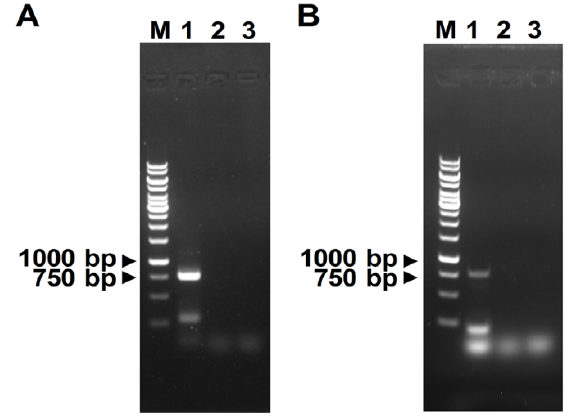
Figure 3. Strand-specific RT-PCR detection of the positive-strand ( A ) and negative-strand ( B ) RNA of watermelon mosaic virus. Lane M, DNA marker (Thermo). Lane 1 and Lane 2 indicate cDNA transcribed from diseased and healthy cotton leaves, respectively. Lane 3 indicates that double-distilled water was used as the negative control.